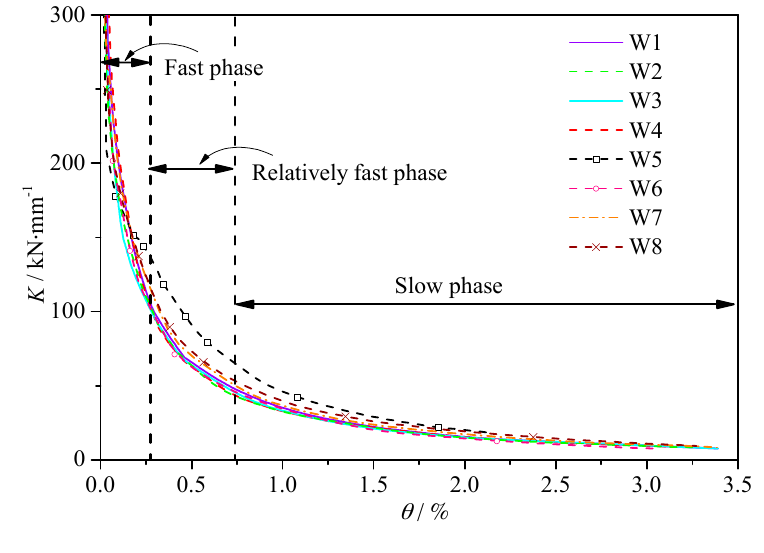
Figure 16. Degradation of stiffness. Table 8. Experimental values of stiffness.